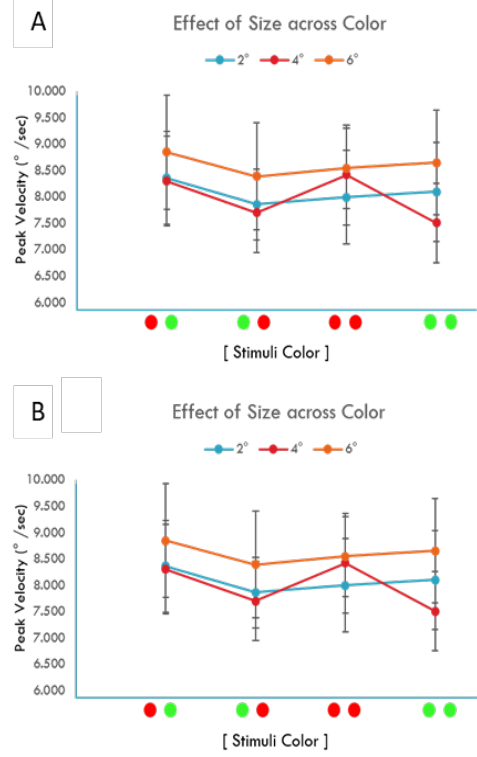
Figure 4: The effect of stimulus target type across color for (A) the left eye response peak velocity and (B) right eye peak response